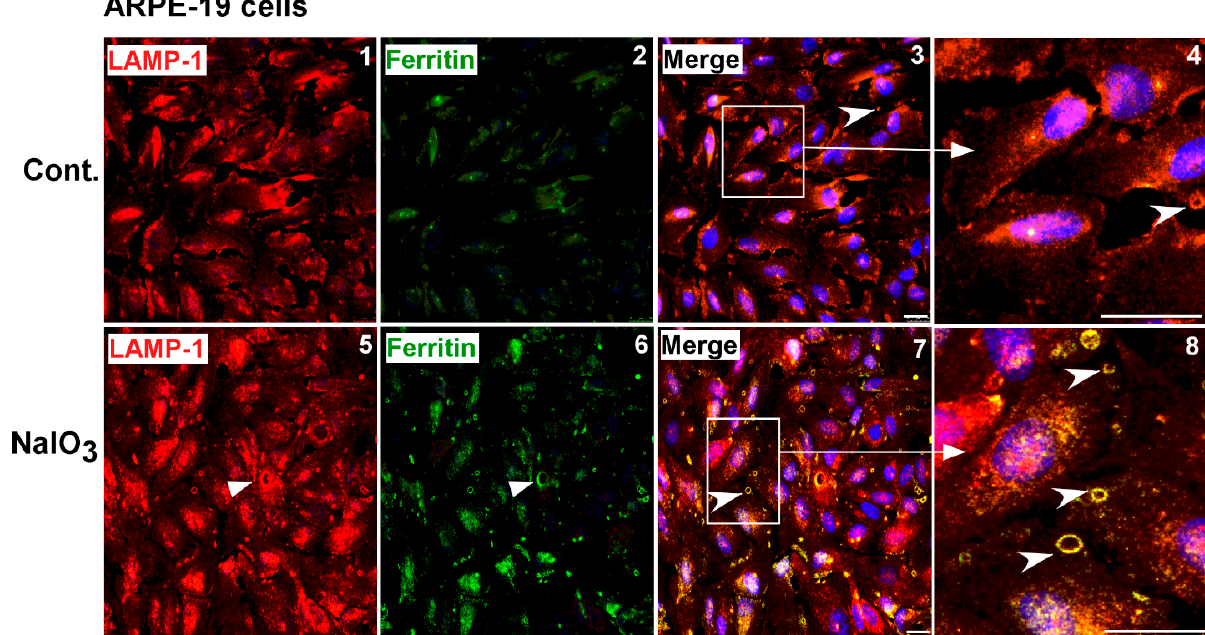
Figure 3. NaIO 3 induces release of ferritin in lysosomal membrane-enclosed vesicles. Co-immunostaining of ARPE-19 cells with goat anti-ferritin and rabbit anti-LAMP-1 antibodies followed by species-specific secondary antibodies conjugated with Alexa Fluor 546 ( red ) and Alexa Fluor 488 ( green ) showed co-localization in intracellular (panels 7, 8, arrowhead) and extracellular (panels 7, 8 vs. panels 3, 4, arrowhead) vesicles in NaIO 3 -treated cells relative to controls. Extracellular vesicles positive for LAMP-1 were also seen in vehicle-treated controls (panels 3, 4, arrowhead). Cells treated with only secondary antibodies showed no reaction (Supplementary Figure S2). Experiments shown in Figure 2E and Figure 3 were conducted simultaneously to maintain scientific rigor and had the same controls. Scale bar: 25 µm.